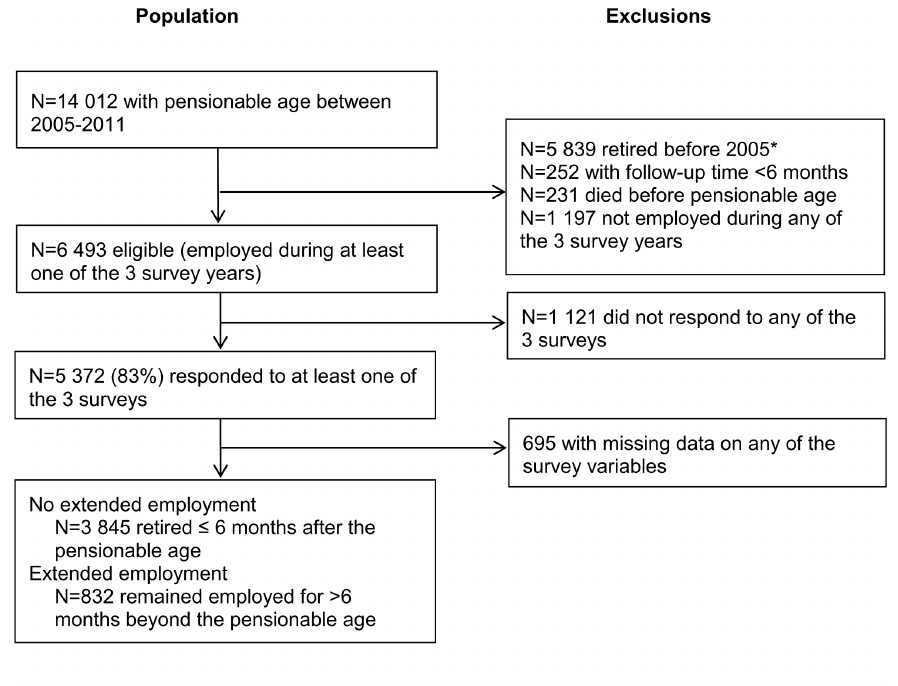
Figure 1. Sample selection procedure.